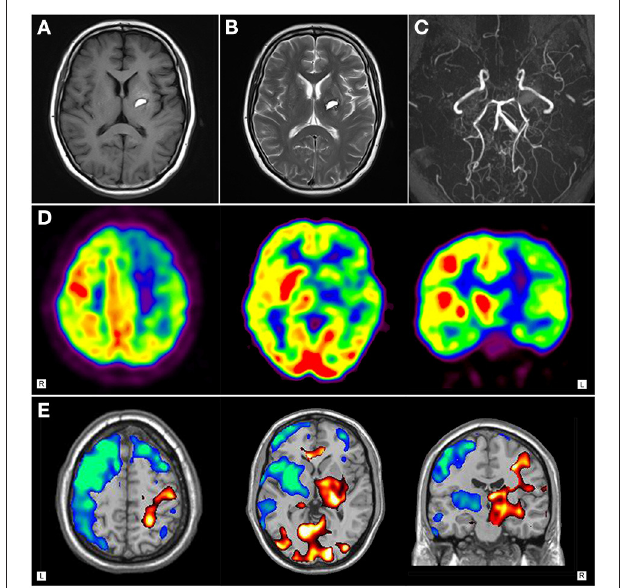
FIGURE 2 | Neuroimaging findings of patient 2. (A) T1-weighted axial and (B) T2-weighted cranial magnetic resonance imaging showed hyperintense signal in the left basal ganglia. (C) Magnetic resonance cerebral angiography revealed severe stenosis of internal carotid arteries in the supraclinoid portion, with numerous collateral vessels. (D) 18 F-FDG PET images and (E) statistical parametric mapping analysis showed hypermetabolism in right striatum and fronto-parietal regions, with diffuse hypometabolism in left brain area.